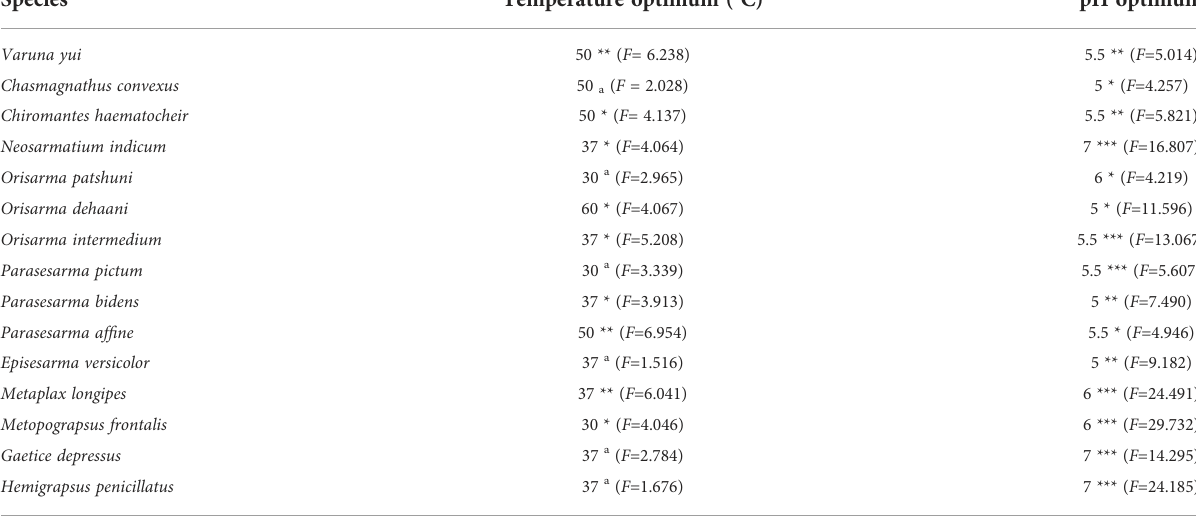
TABLE 2 Temperature and pH optima of EG activity for the 15 grapsoid crabs. Species Temperature optimum (°C) pH